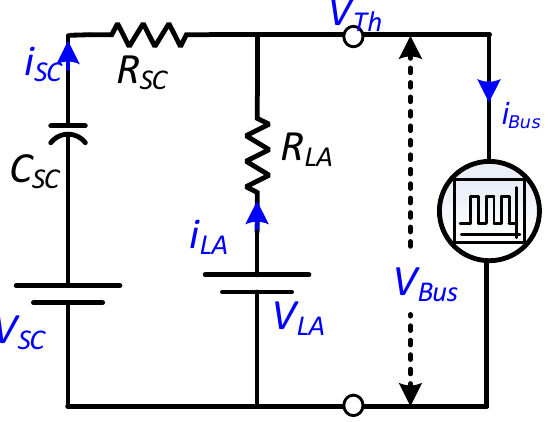
Figure 5. Equivalent model of the passive HESS configuration. The SC is modeled with the series-connected equivalent resistance R SC , a definite initial voltage V sc and the huge value of capacitance C SC , whereas the lead-acid battery is modeled with the series-connected equivalent resistance R LA and a constant voltage source V LA